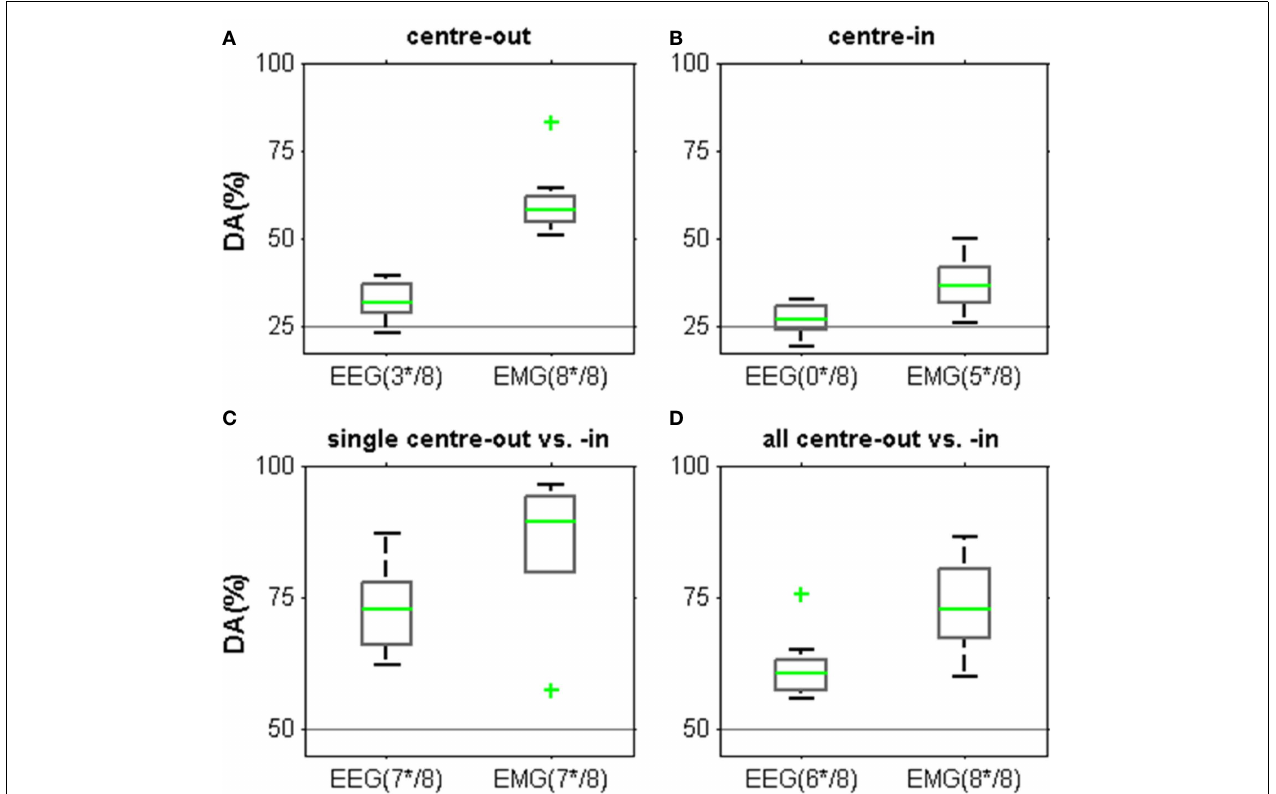
results for the endpoints of center-in movements (which terminated all on the center button).There was no significant EEG-based DA for any of the subjects. EMG-based DA was lower than for the endpoints of center-out movements, yielding significant DA in five subjects. (C) Decoding results for the endpoints of the best pair of a center-out and a center-in movement in each subject (see Table 4 ).This yielded highest EEG and also EMG DA values. (D) Decoding whether an endpoint was reached after center-out as opposed to center-in movements based on all eight movement classes yielded lower DA values than (C)